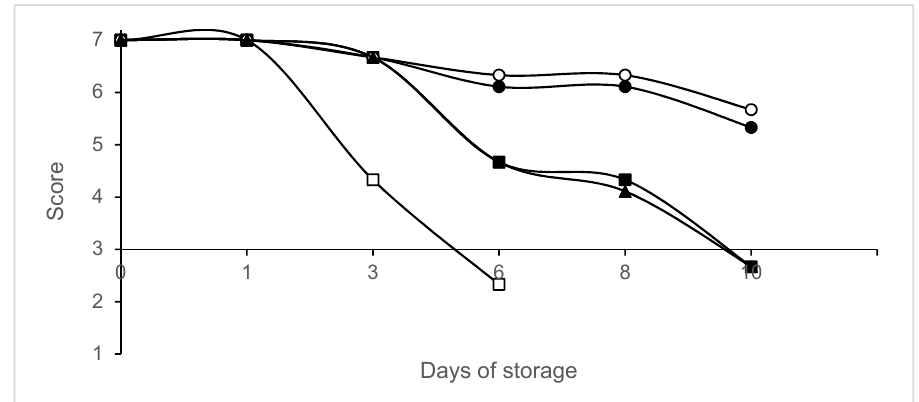
Figure 4. Changes in sensorial scores in packaged legs. Packaging conditions: Batch A0, air ( □ ); Batch A20, 80% N 2 /20% CO 2 ( ▪ ); Batch A40, 60% N 2 /40% CO 2 ( • ); Batch A60, 40% N 2 /60% CO 2 ( ◦ ); Batch AV, vacuum ( ▲ ). Data shown are each the mean value of six determinations.